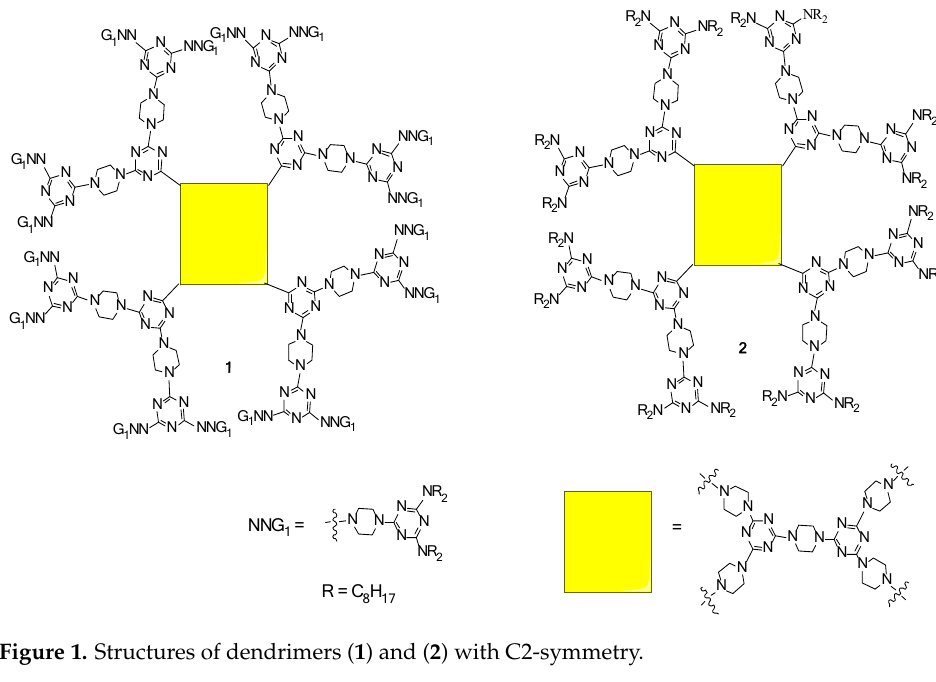
Figure 1. Structures of dendrimers ( 1 ) and ( 2 ) with C 2 -symmetry.